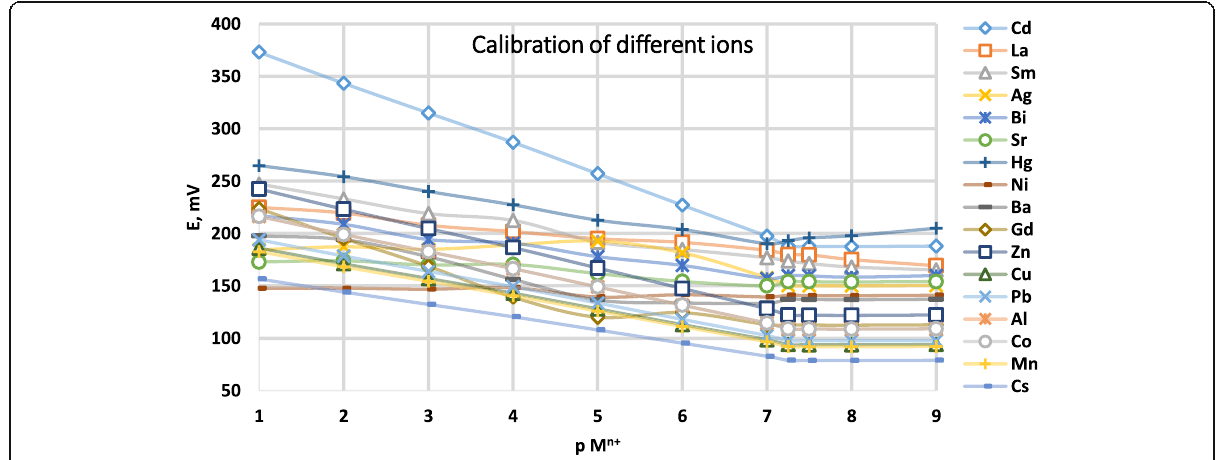
Fig. 8 Calibration graphs of Cd(II)-CPE sensor for different ions